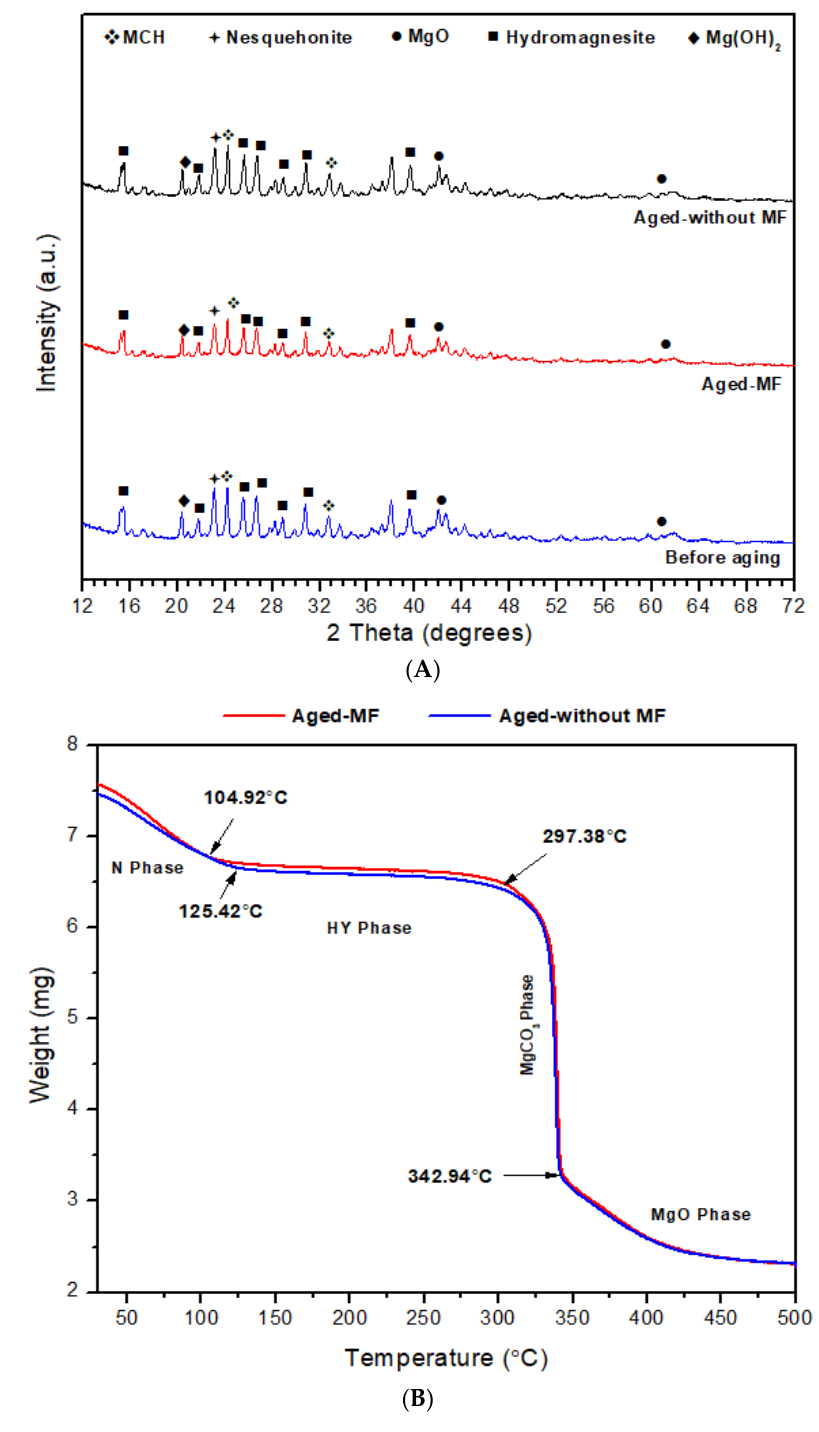
Figure 2. ( A ) XRD patterns for electrospun MgO-based nanocomposites, as prepared, after aging under MF and aging not under MF. ( B ) The thermal decomposition during the aging process under MF and no MF at room temperature.